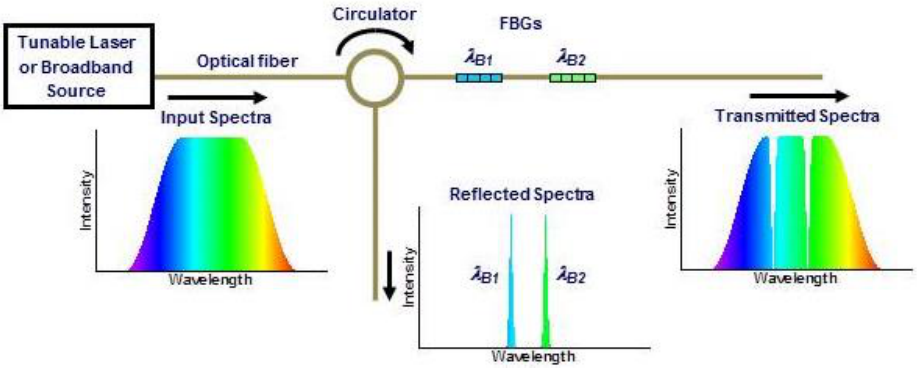
Figure 1. Typical sensor interrogation scheme for two inline fiber Bragg gratings (FBGs) with Bragg wavelengths λ B 1 and λ B 2 .